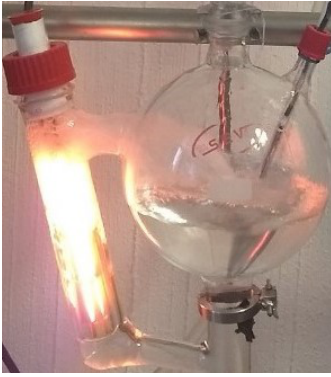
Figure 2. Distillation column heating